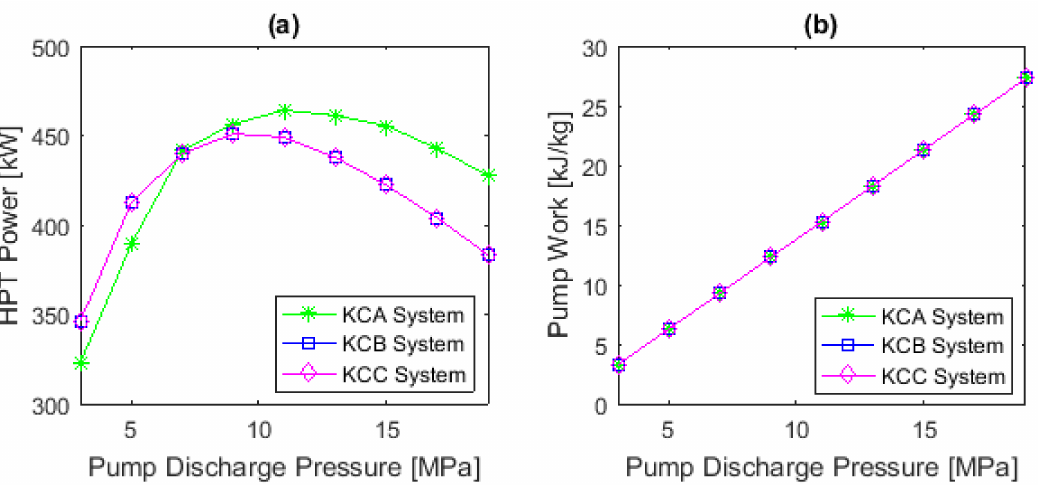
Figure 8. Effect of pump discharge pressure on the: ( a ) HPT power and ( b ) pump performance. We notice mechanical power peaks at 12 MPa for the KCA system (3200.53 kW), at about 15 MPa for the KCB system (2501.499 kW), and 9 MPa (3127.68 kW) for the KCC system. The best thermal efficiency is 26.93% at 12 MPa (for KCA), 22.62% at 15 MPa (for KCB), and 31.28% at 9 MPa (for KCC), respectively. KCA and KCC systems